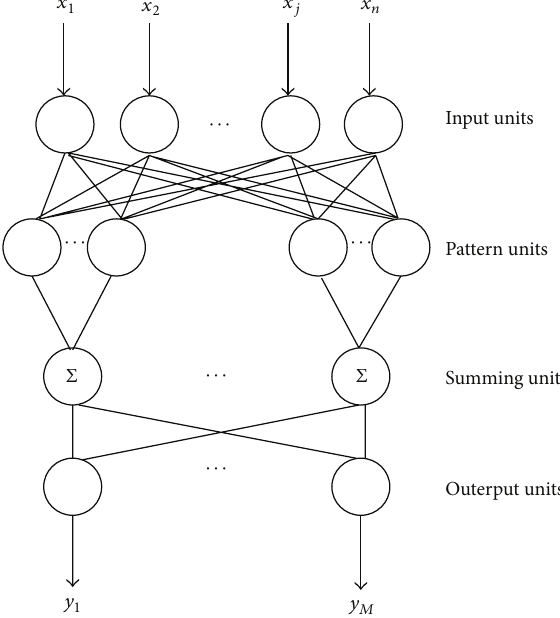
Figure 5: The topological structure of